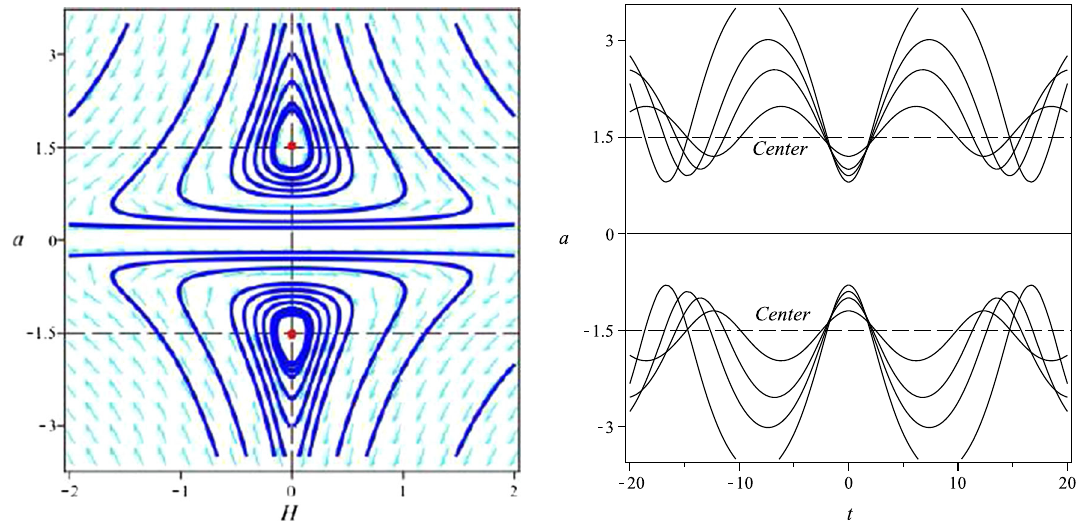
Fig. 3 (Left) dynamical behavior of the system around the critical points. (Right) time evolution of the scale factor a corresponding to the trajectories in phase space for the case of γ = 0, k = 1, α = 1 and β = −